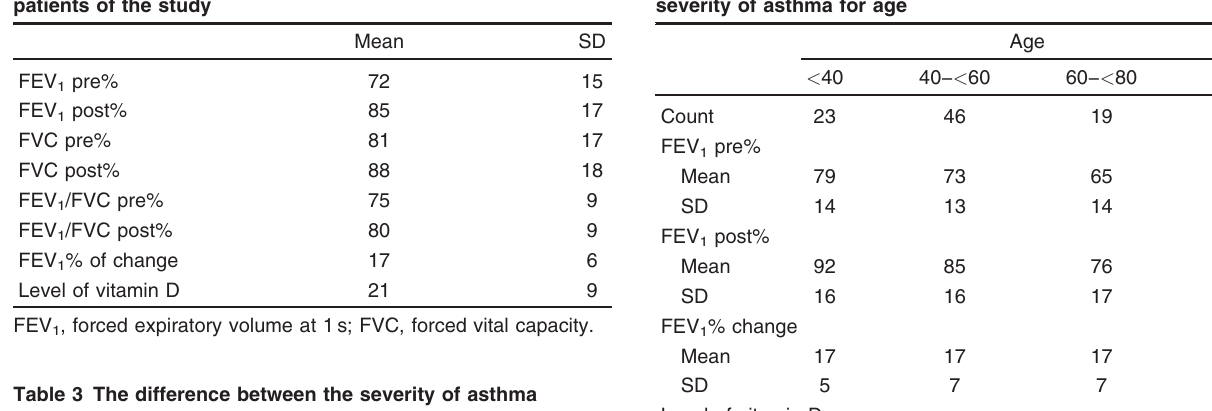
Table 3 The difference between the severity of asthma (according to pre-forced expiratory volume at 1s) and vitamin D levels Severity of asthma (according to pre-FEV 1 )